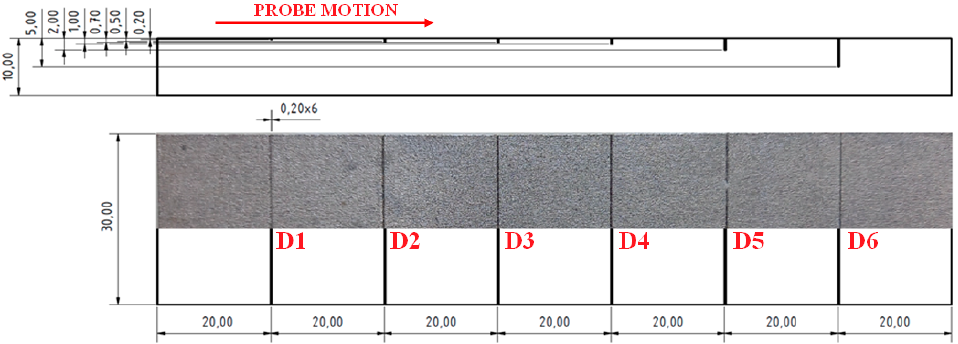
Figure 11. S2 sample.